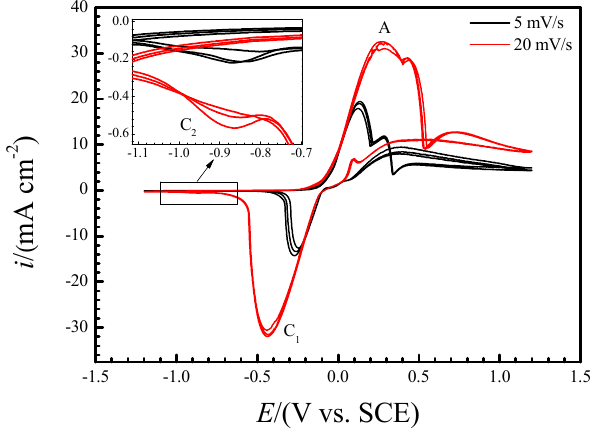
Figure 2. Snapshots of the copper surface in neutral 3.5% (wt.) NaCl solution at OCP and with applied potential varying from − 1.2 to 0.60 V and then reversing to − 1.2 V, which shows that a porous film was formed on copper surface with the electrode potential polarized to about 0 V and it was reduced after the potential reversed to − 1.2 V.